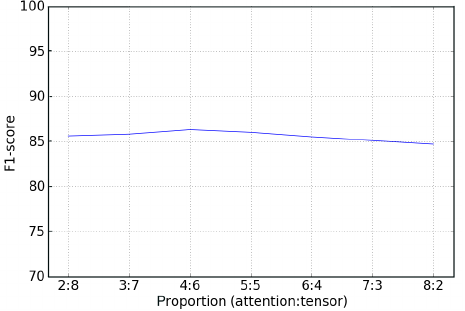
Fig. 8 Proportions of attention and tensor